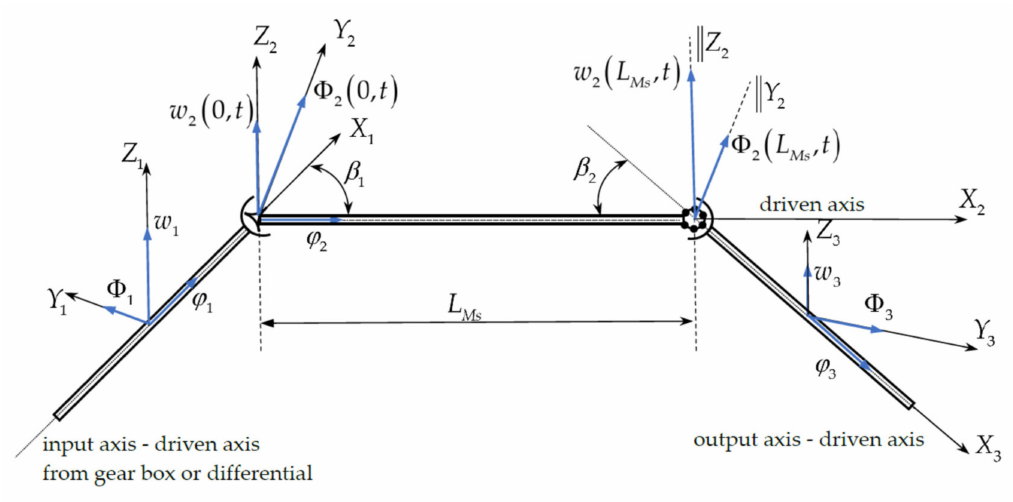
Figure 5. Schematic representation of an automotive